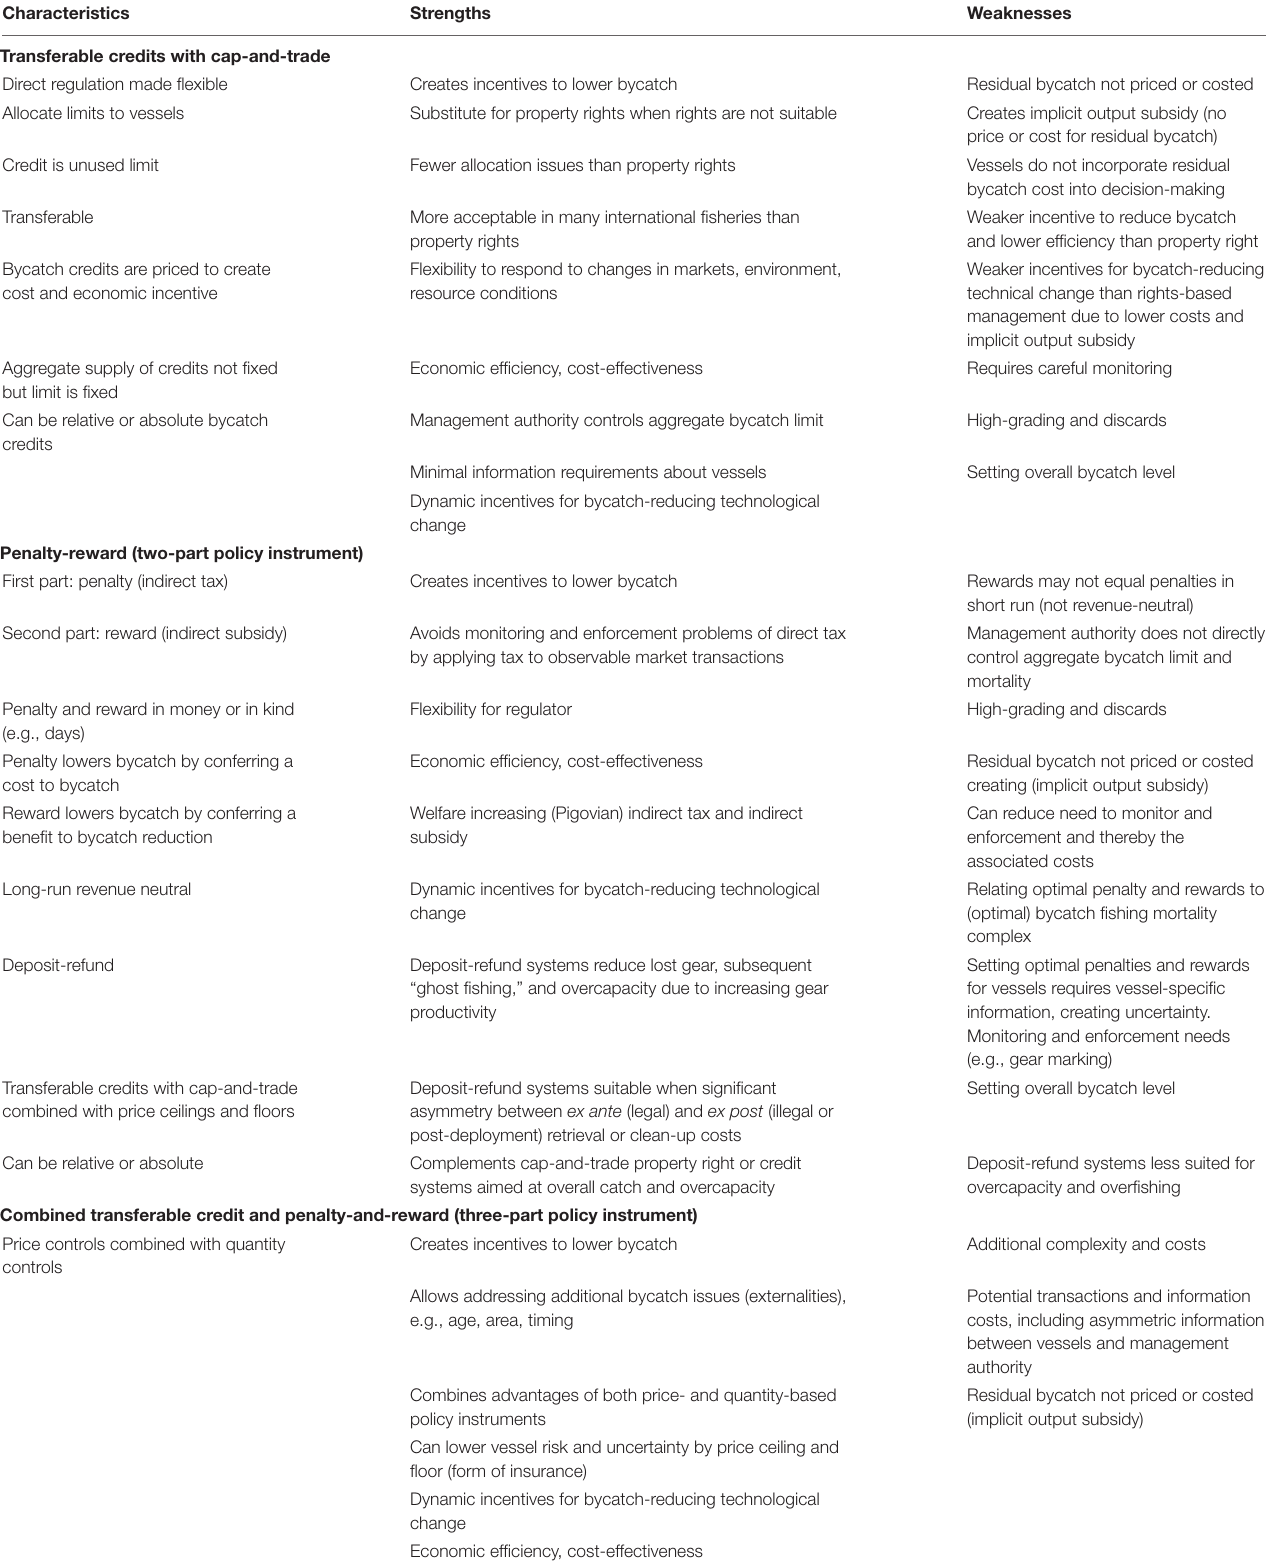
TABLE 1 | Features, strengths, weaknesses of three credit